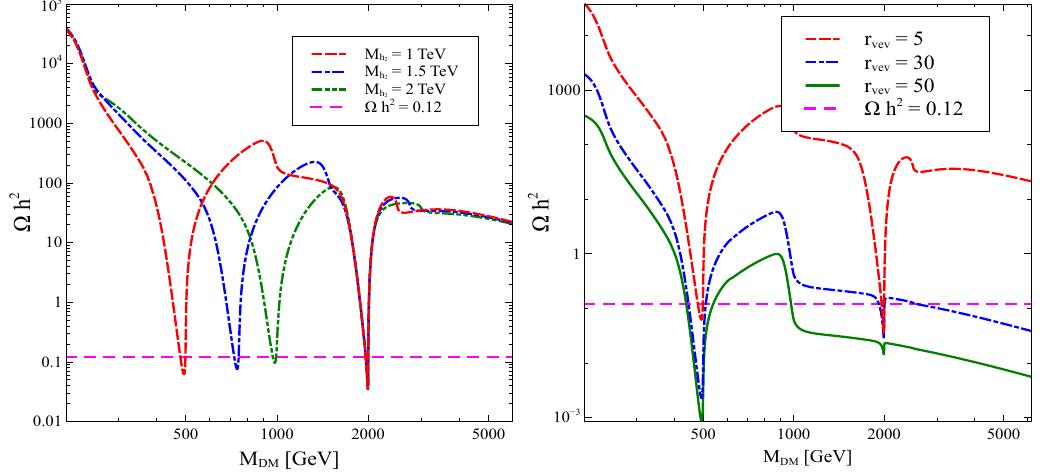
Figure 8 . Left (right) panel: variation of relic density with the DM mass for three di(cid:11)erent values of h 2 mass (VEV ratio). While other BSM parameters have been kept (cid:12)xed at r vev = 5, M N M N 0 = 361 : 4 GeV, M N = M N 0 = 296 : 2 GeV, M N = M N 0 = 111 : 0 GeV, M h 2 3 1 2 3 M h = 250 GeV, M Z ( g BL ) = 4000 (0.1) GeV, h e(cid:22) = 1 : 58, h e(cid:28) = 1 : 63, h (cid:22)e = 2 : 38, h (cid:28)e = 1 : 34, 3 BL sin (cid:12) = 0 : 07, (cid:1) M = M 2 M 1 = M 2 M DM = 50 GeV and for a 1 , a 2 and a 3 see appendix (cid:0) (cid:0)